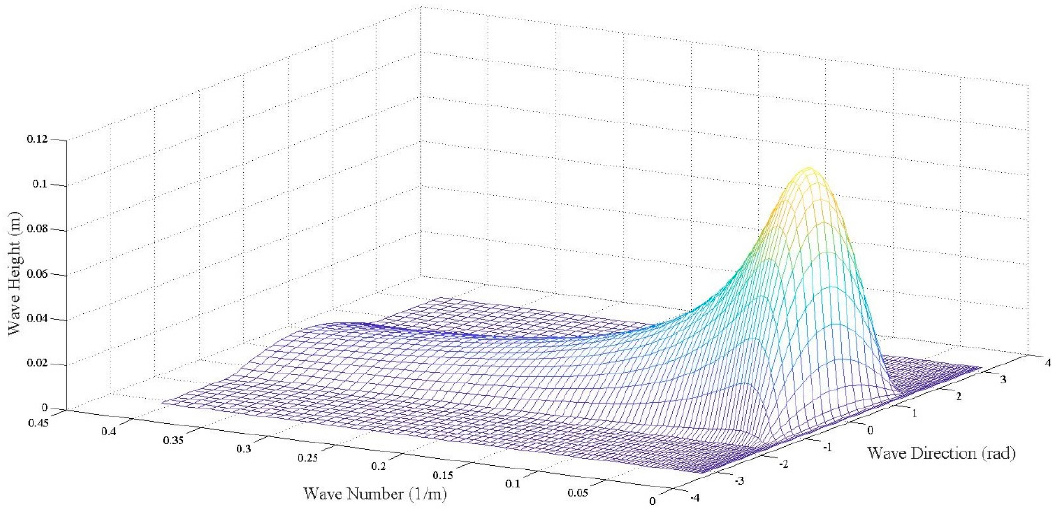
Figure 2. The relation of wave number, wave direction and corresponding wave height in synthetic radar images.